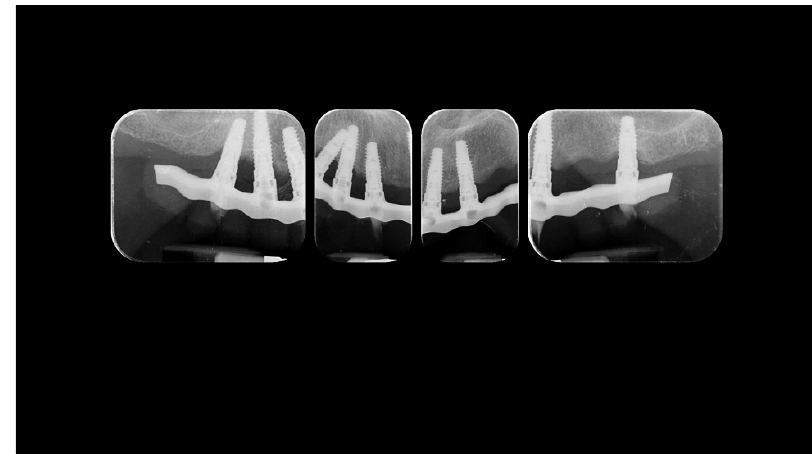
Figure 16. Radiographic status of the new work 1 year after delivery.